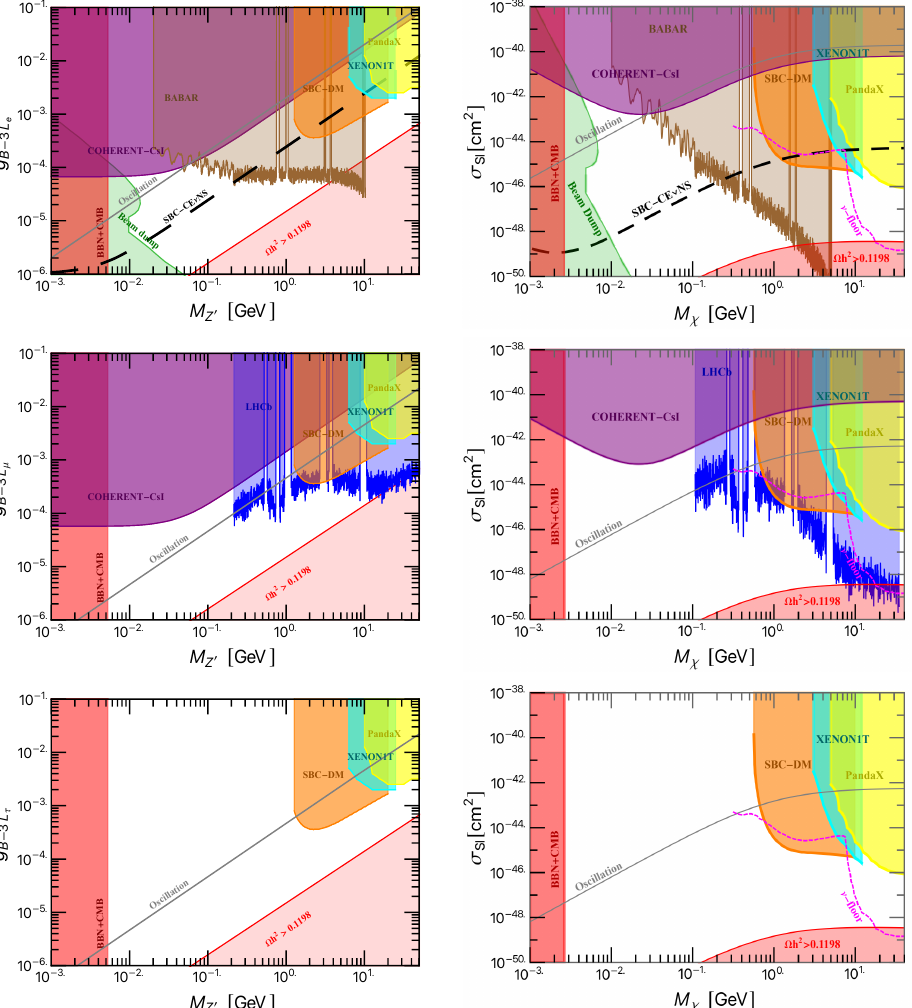
Figure 5 . Same as figure 2 but for MIV U(1) 0 models as given by table 2. The limits from global analysis of neutrino oscillation data are shown with the gray line. These limits are obtained in the framework of three flavor neutrinos with NSI generated by the corresponding U(1) 0 models [24]. agreement with the latest neutrino data, but predict no